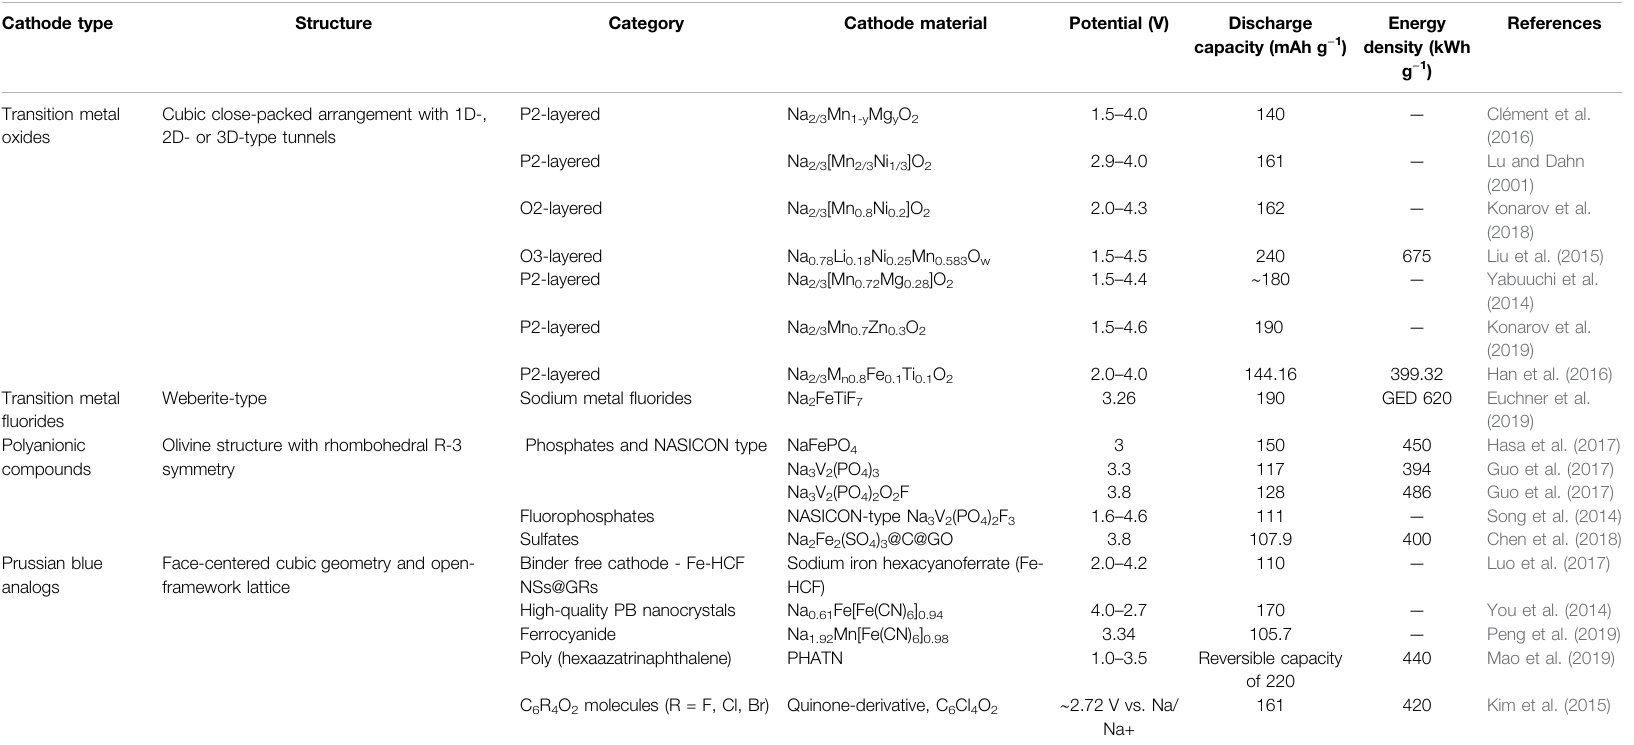
TABLE 1 | Performance characteristics of cathode materials for organic sodium-ion